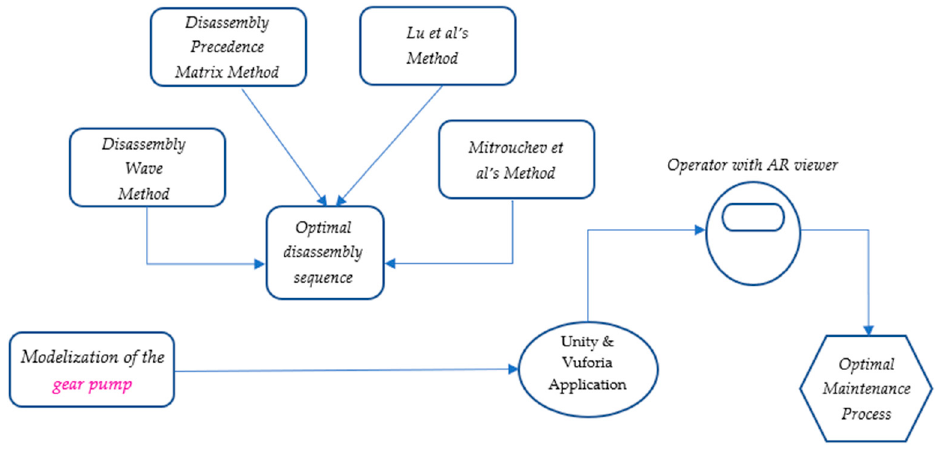
Figure 2. Logical diagram of the work.